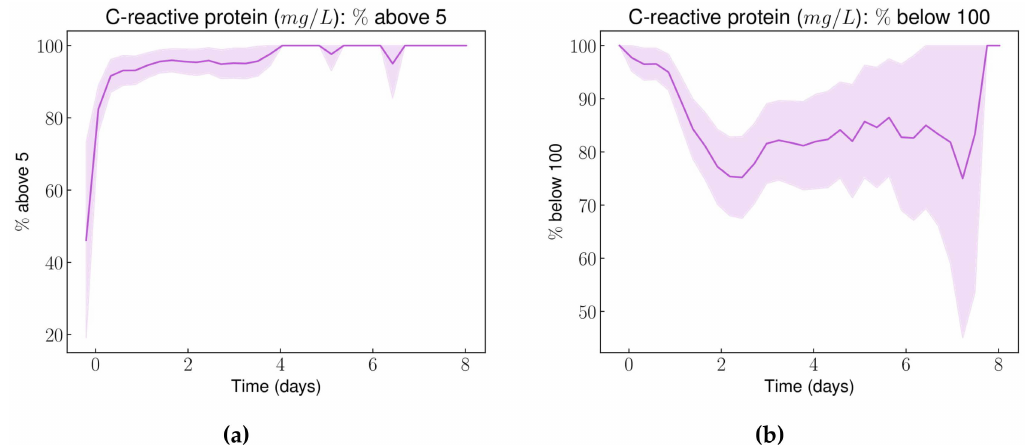
FigureA6. C-reactiveprotein: ( a )percentageofpatientswithCRP > 5mg / Lthroughoutnon-complicated VOC-related hospital stays; ( b ) percentage of patients with CRP < 100 mg / L throughout non-complicated VOC-related hospital stays.